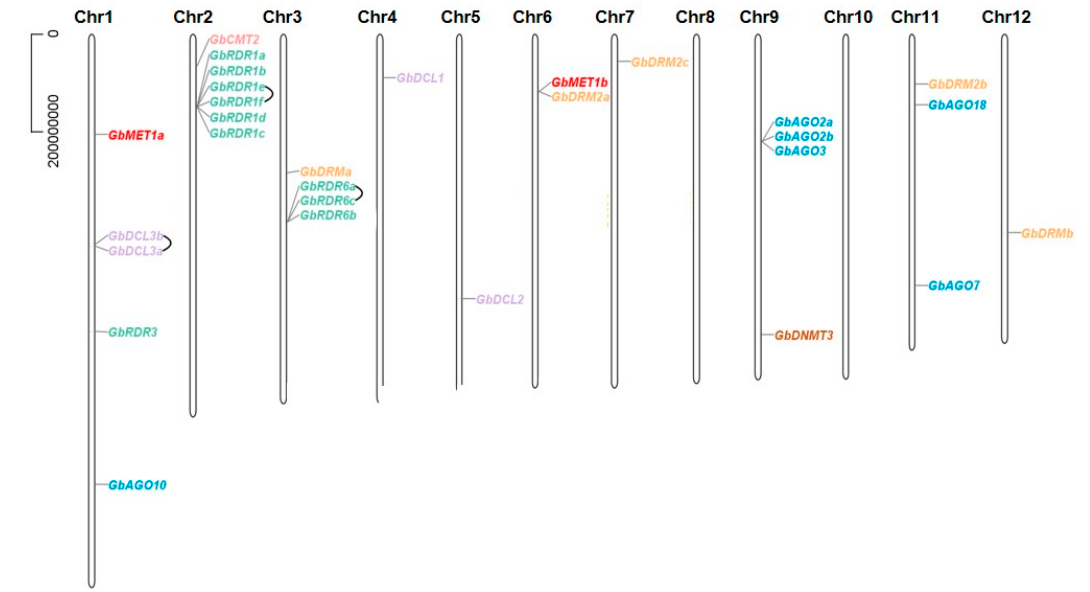
Figure 3. Chromosome location of DNA methylation pathway genes in the G. biloba genome. Different colors indicate different gene families. Short black curves represent the tandem duplications.